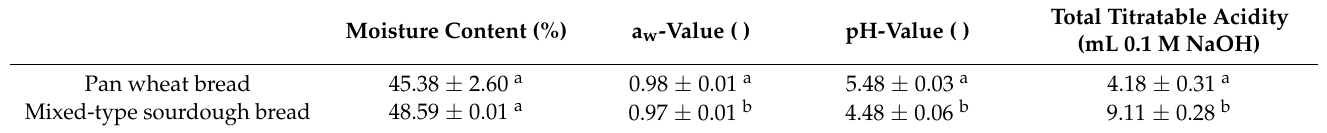
Table 1. Results of initial bread characterization (x ± STD, n =